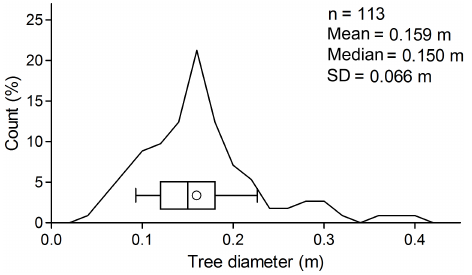
Figure 9. Histogram and box plot of diameter of trees fallen on the opposite slope of the Langtang village. Box, line, and circle in the box-and-whisker plot denote interquartile, median and mean, and 1 standard deviation, respectively. Observation site is shown in Fig.